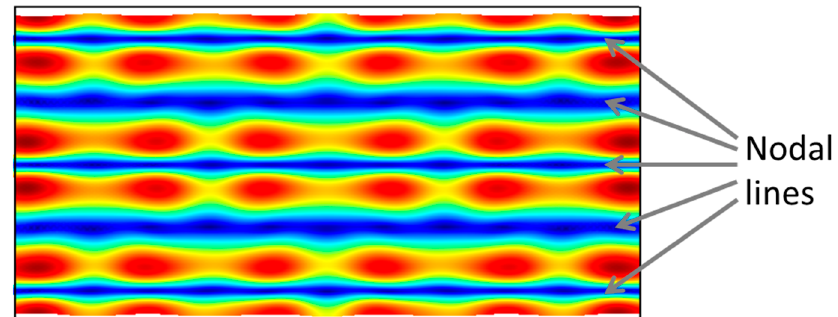
Figure 7. Displacement profile of the 5th order width-extensional (WE) mode of vibration.